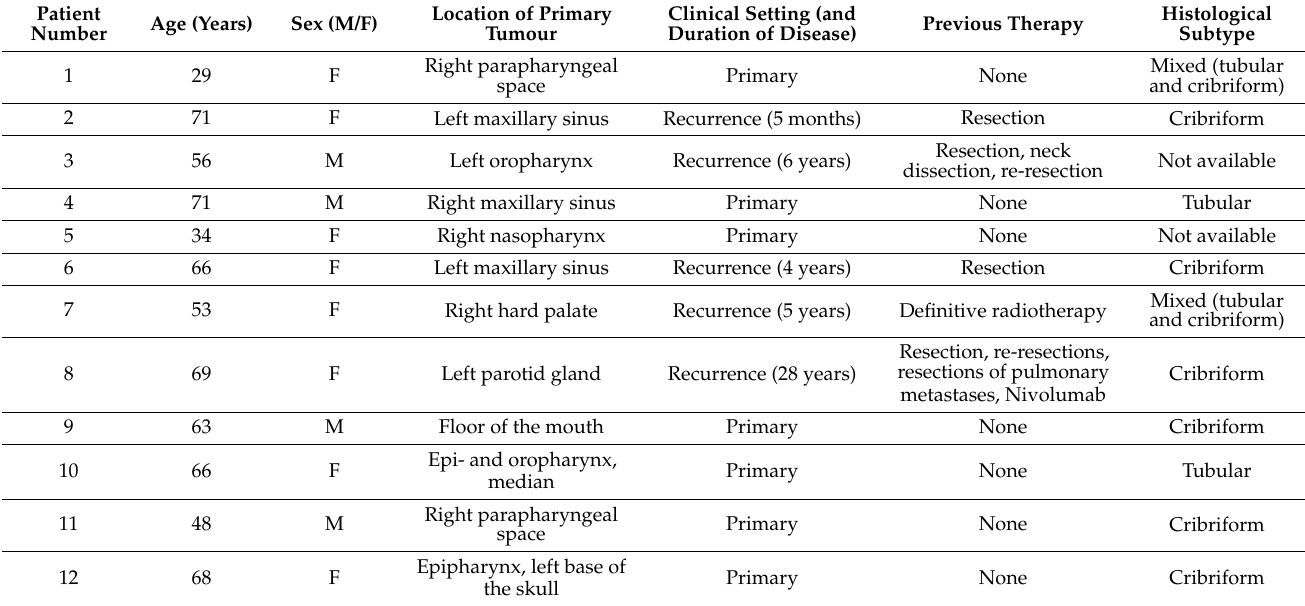
Table 1. Clinical and histological characteristics of 12 patients with